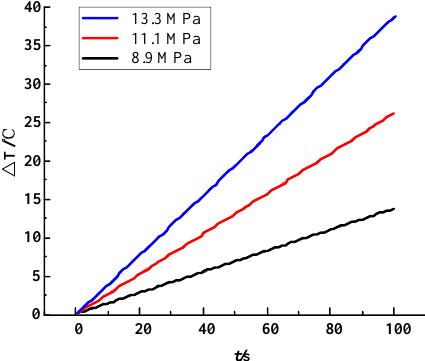
Figure 8. Temperature variation of the bit under different stress states.